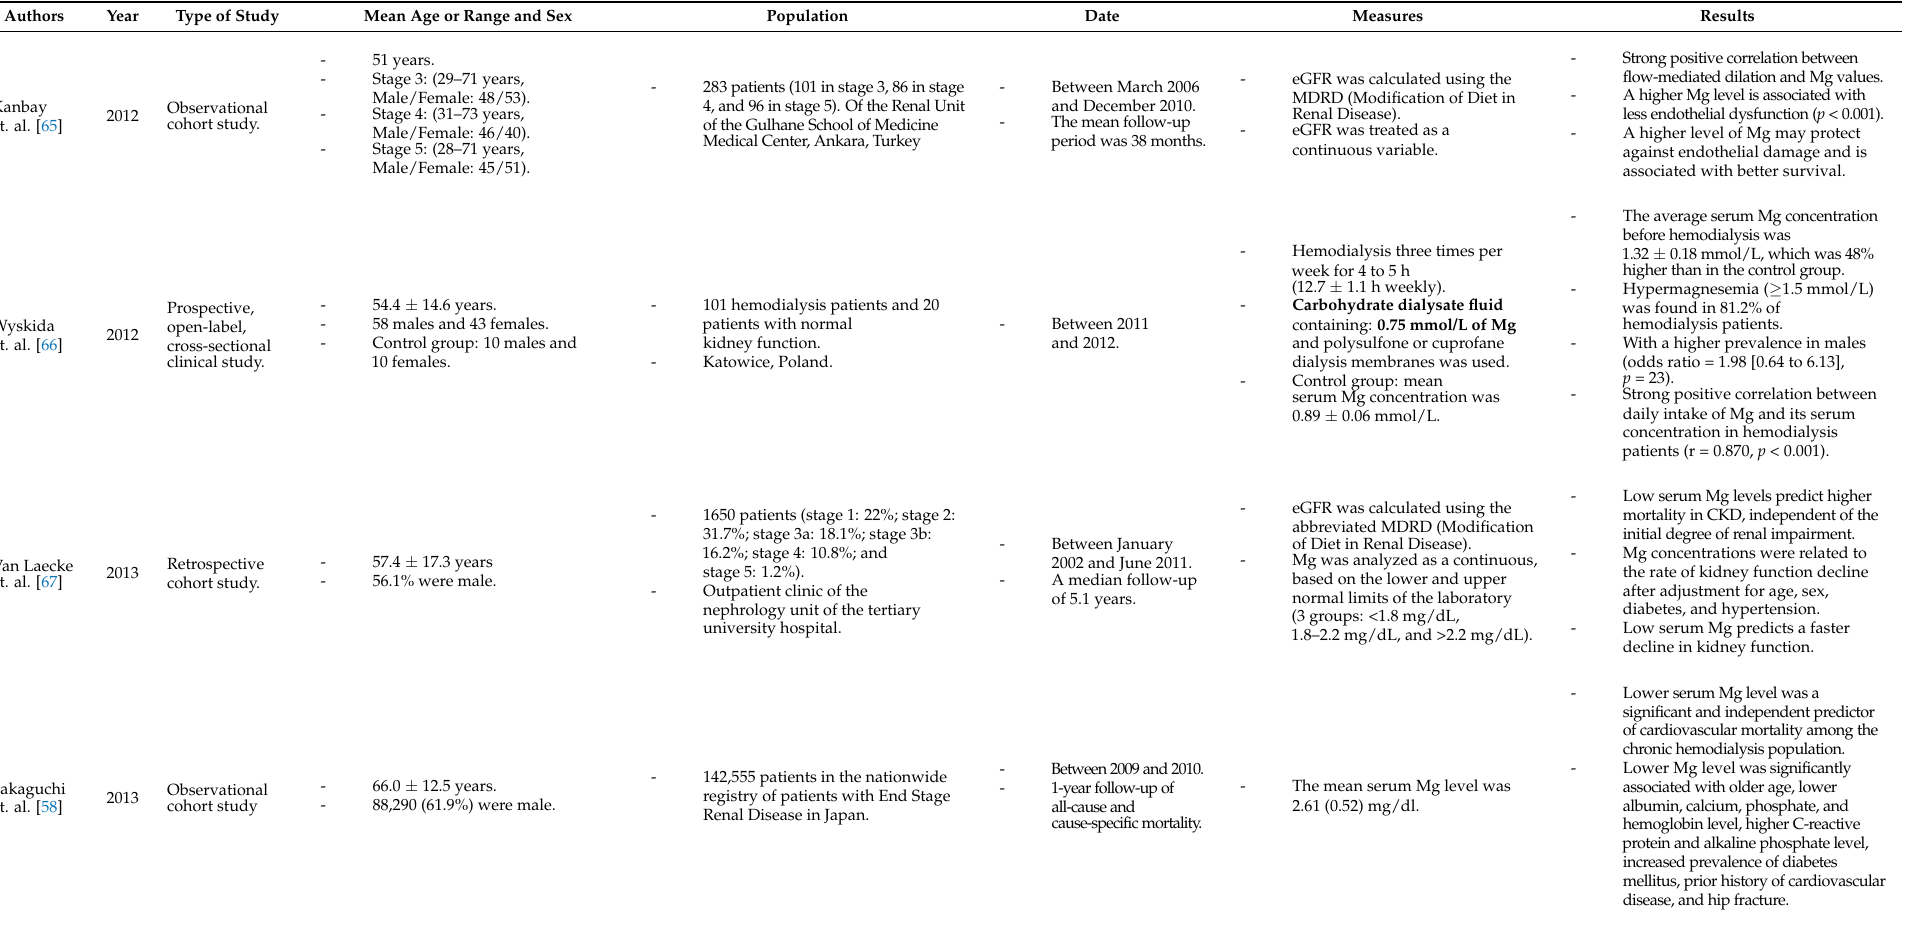
Table 1. Characteristics of the studies included in this review are divided into sections relevant to the purpose of this study. Abbreviations: Magnesium (Mg), chronic kidney disease (CKD), Estimated Glomerular Filtration Rate (eGFR), Modification of Diet in Renal Disease Equation (MDRD), Chronic Kidney Disease Epidemiology Collaboration equation (CKD-EPI).